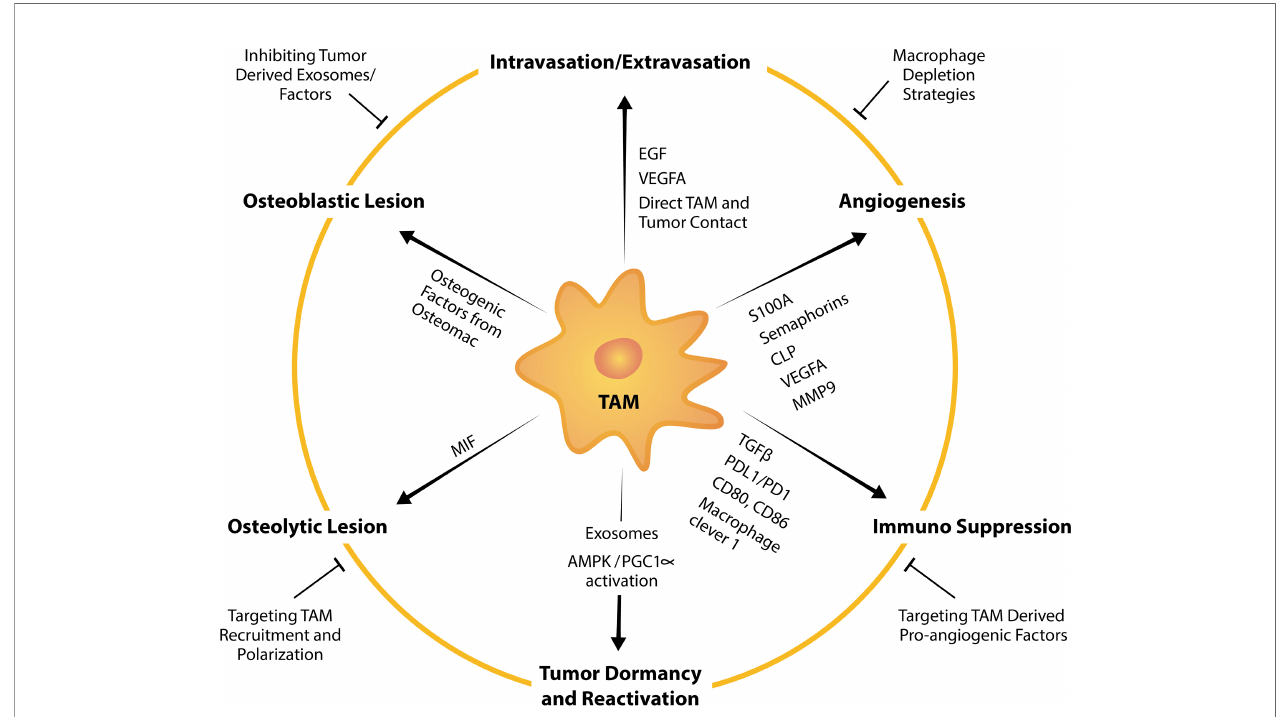
FIGURE 3 | TAM factors and markers that facilitate tumor bone metastasis and strategies to suppress TAM-mediated promotion of metastasis. TAMs in fl uence tumor intravasation, extravasation, angiogenesis, dormancy, reactivation, formation of osteolytic and osteoblastic lesions, and immunosuppression by expressing or releasing pro-tumorigenic factors. For example, TAMs are a potent source of a multitude of pro-angiogenic factors including VEGFA, MMP9 and those from the EF- hand calcium-binding cytosolic (S100A) protein family, semaphorins family and chitinase-like proteins. Strategies to target TAM pro-tumorigenic functions summarized in this schematic include broad macrophage depletion strategies, targeting pro-angiogenic factors from TAMs, inhibiting TAM recruitment, TAM repolarization and inhibiting tumor-derived exosomes or factors that instigate TAM and tumor pathological